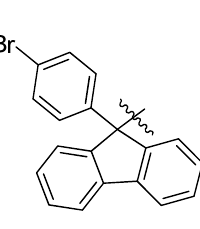
Figure 14. p -Bromophenylfluorenyl.